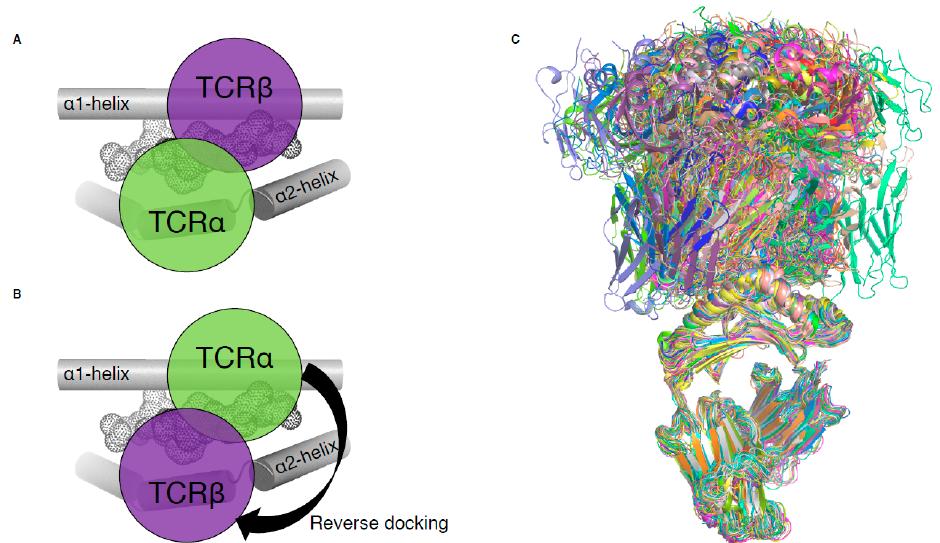
Figure 2. TCR docking on pMHC-I complex. ( A ) Schematic of canonical TCR docking on pMHC-I, whereby the TCR α (green) is above the MHC-I α 2-helix (grey tube) and the TCR β chain (purple) is above the MHC-I α 1-helix (grey tube). ( B ) Schematic of reversed docking for TCR, with the arrow indicating a 180 ° shift from the canonical docking mode (shown on ( A )). Here, the TCR α (green) is above the α 1-helix, while the TCR β chain (purple) is above the α 2-helix. The peptide is represented as dots on panels ( A , B ). ( C ) Overlay of all TCR–pMHC-I structures from Table 1, aligned on the MHC-I antigen binding cleft (residues 1–180).